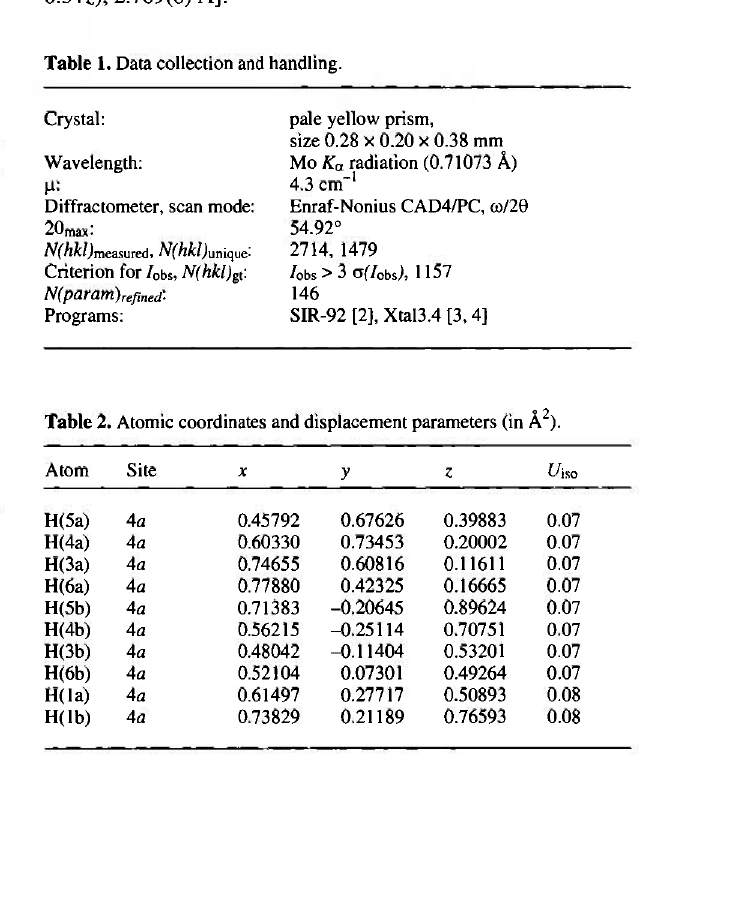
Table 1. Data collection and handling.